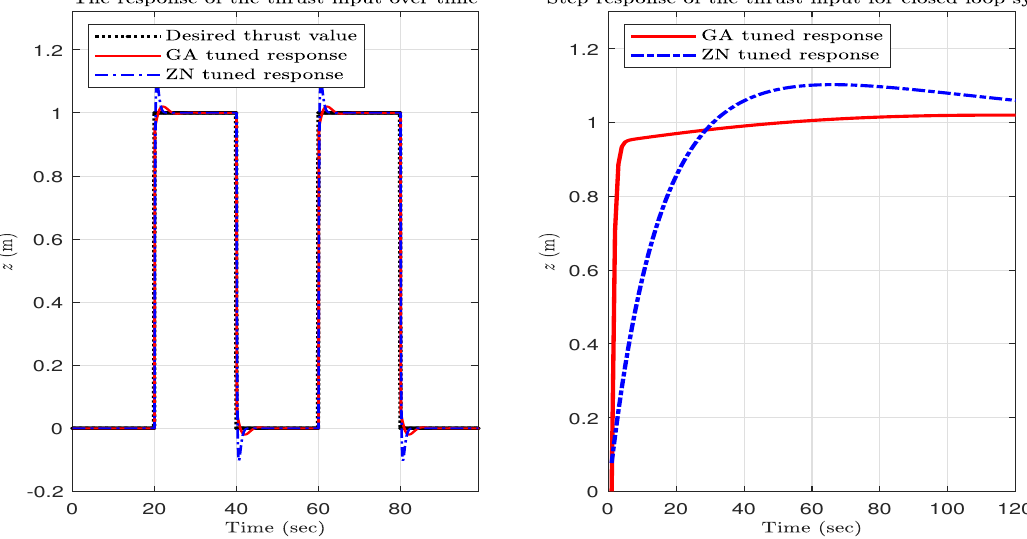
Figure 10. Simulated output responses of the thrust input of a quadcopter using GA and ZN methods.